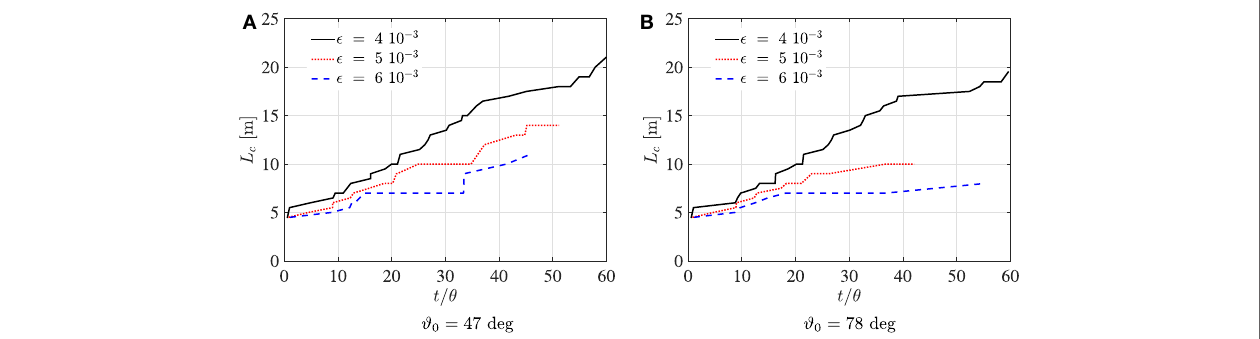
FIGURE 14 | Crack length L c as a function of time for two configurations corresponding to two tilting angles. The hosting triangular lattice and the parameters for the two lattices with resonators are reported in Table 2 . (A) ϑ 0 = 47°. (B) ϑ 0 = 78°.